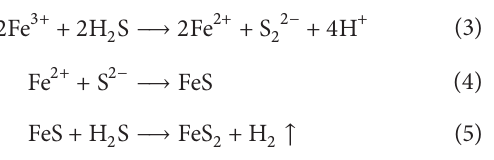
the natural pyrite material has the strong and sharp diffrac- tion peaks, indicating the high crystalline nature of mineral powder. The micropyrite has sharper diffraction peaks than nanopyrite material, suggesting the higher crystallinity of micropyrite. The pyrite nanowires obtained different peak intensities than the others. The peak (421) is the sharpest for pyrite nanowires while (200) peak is the sharpest for the other samples. This can be attributed to the different morphology for the pyrite